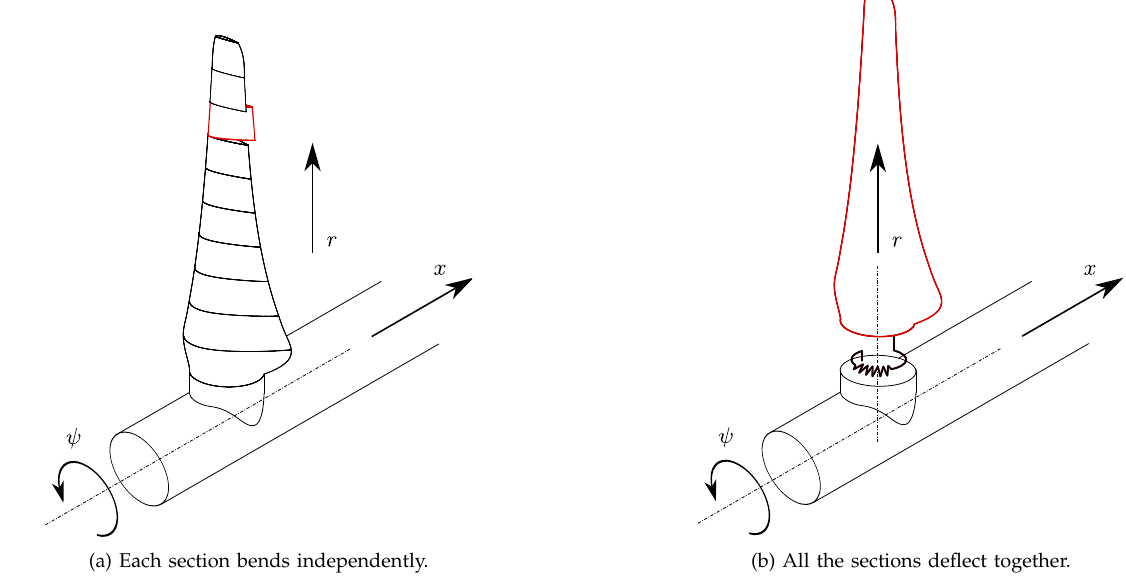
Fig. 1: Two possible concepts for morphing